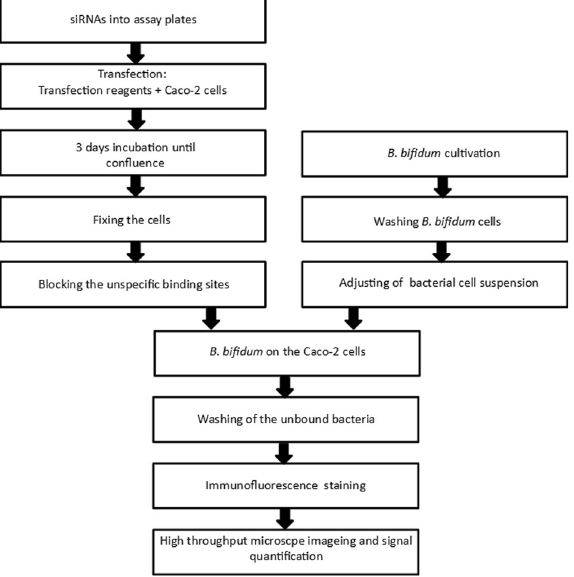
Fig. 1 Work fl ow of the screening assays. All three screenings were performed using the same protocol.